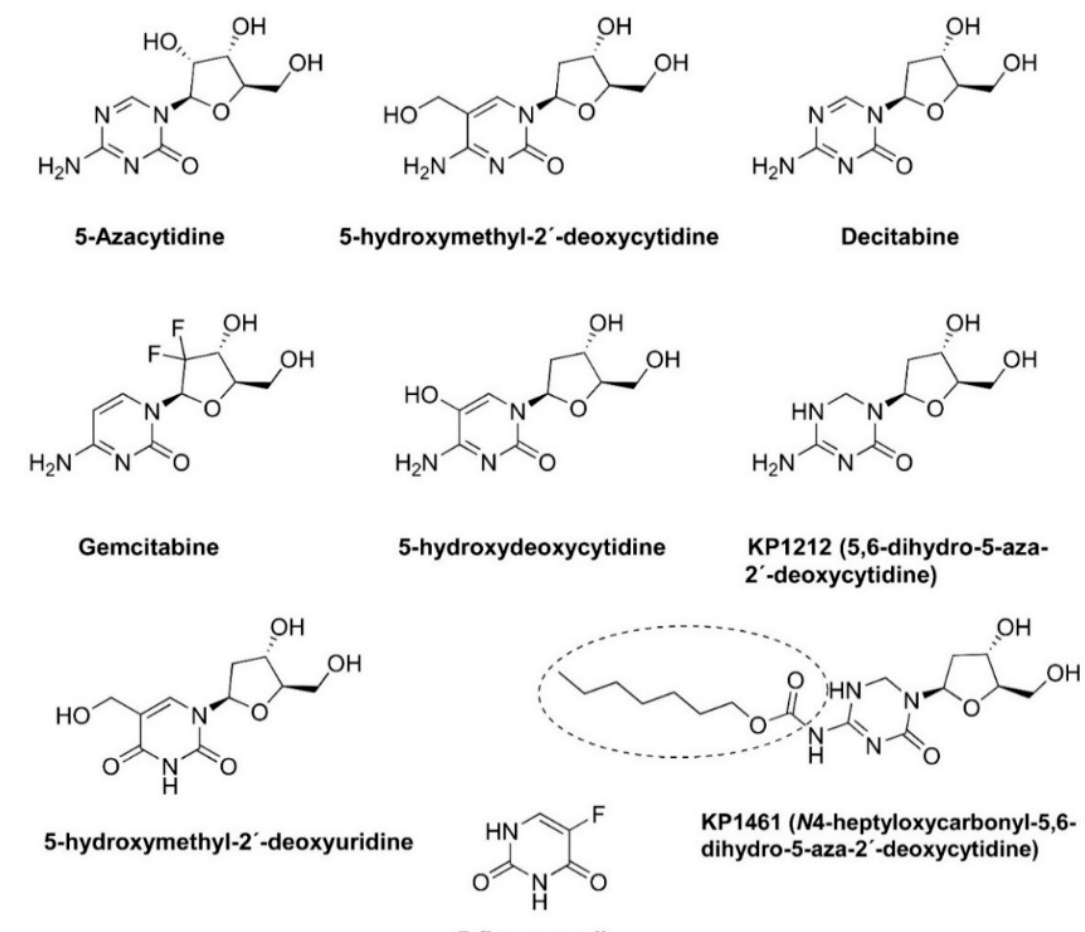
Figure 1. Chemical structures of mutagenic base and nucleoside analogs and prodrugs used in lethal mutagenesis experiments. KP-1461 is a prodrug of KP-1212.